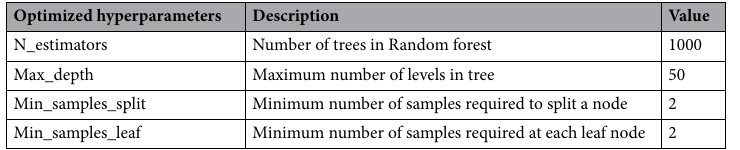
Table 2. Random Forest